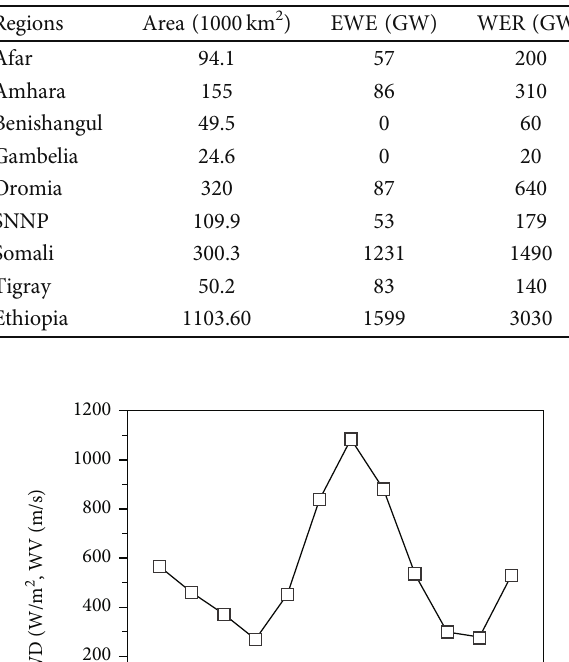
Table 7: Wind resource in Afar region and di ff erent regions of Ethiopia at h = 50 m .